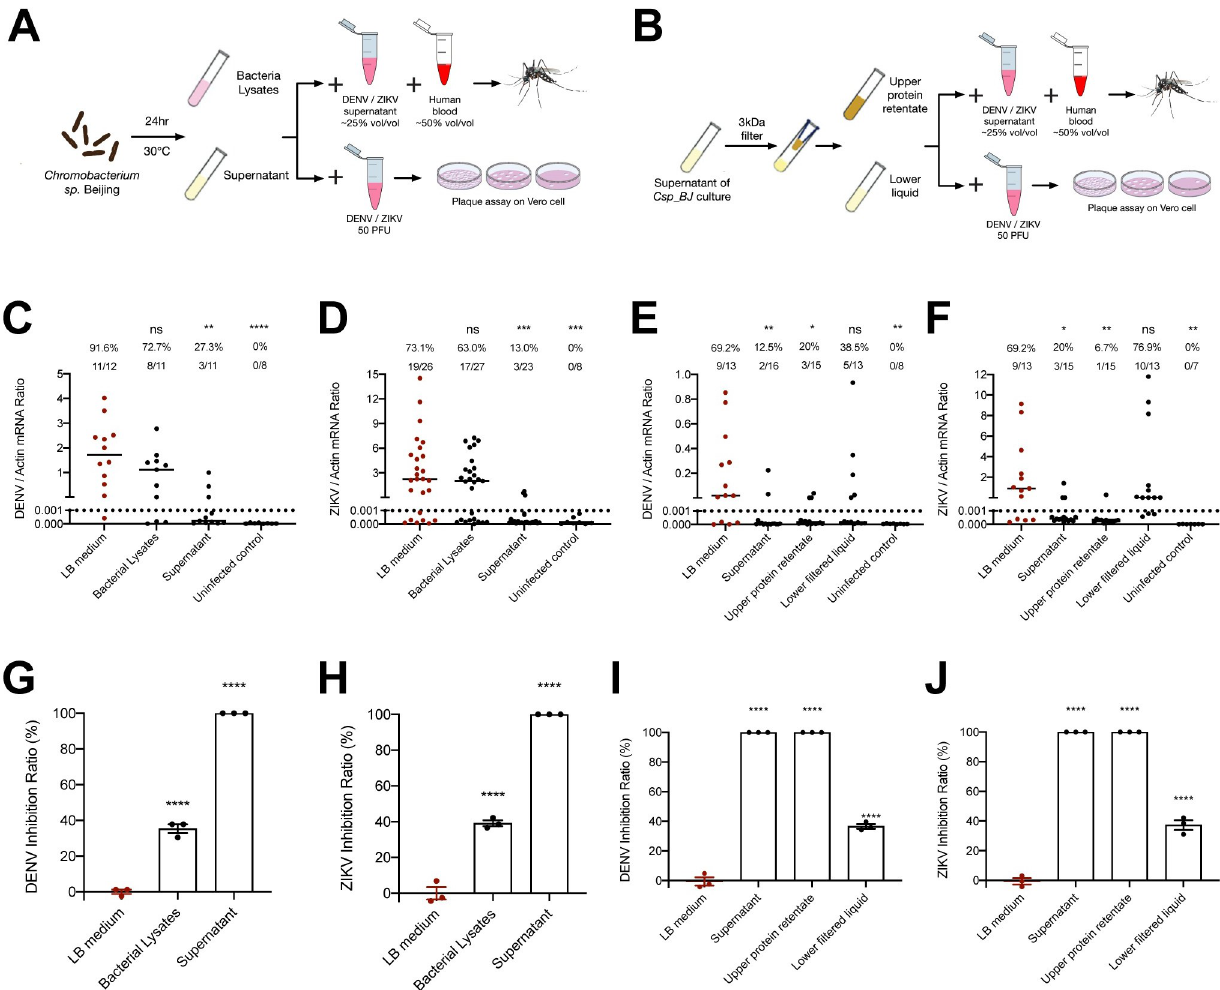
Fig 2. Secreted effector(s) from Csp_BJ inhibit DENV and ZIKV infection in both A . aegypti and Vero cells. (A, B) Schematic representation of the study design. (A) A Csp_BJ suspension was separated into bacterial cells and culture supernatant by centrifugation. Either the bacterial cell lysate or the culture supernatant (25% v/v) was mixed with human blood (50% v/v) and DENV or ZIKV virus supernatant (25% v/v) for membrane blood feeding of antibiotic-treated A . aegypti . Either the bacterial lysates or the culture supernatant (50% v/v) mixed with 50 PFU of DENV or ZIKV in VP-SFM medium (50% v/v) were incubated for 1 hr before being used for infection of Vero cell monolayers. Positive and negative controls are described in details in the Materials and Methods section. (B) Either the upper retentate or the lower liquid filtrate (25% v/v) was mixed with human blood (50% v/v) and the viruses (25% v/v) for membrane blood feeding of antibiotic-treated A . aegypti . Either the retentate or the filtrate (50% v/v) was mixed with 50 PFU of DENV or ZIKV in VP-SFM medium (50% v/v) and incubated for 1 hr before inoculation into Vero cell monolayers. Positive and negative controls are described in details in the Materials and Methods section. (A, B) Mosquito infectivity was determined by RT–qPCR at 8 days post blood meal. The final DENV or ZIKV titre was 1 × 10 5 PFU/mL for oral infection. (C, D, G, H) Secreted factor(s) from Csp_BJ inhibited DENV and ZIKV infection in mosquitoes or Vero cells. (C, D) Mosquito infection rate after oral supplementation of cell lysates or culture supernatant of Csp_BJ along with DENV (C) or ZIKV (D). (G, H) Inhibition rate in the presence of cell lysates or culture supernatant of Csp_BJ following infection by DENV (G) or ZIKV (H) in Vero cells, as determined by plaque formation assay. (E, F, I, J) Proteins in the supernatant inhibited DENV and ZIKV infection in mosquitoes or Vero cells. (E, F) Mosquito infection rate after oral supplementation of different components of Csp_BJ culture along with DENV (E) or ZIKV (F). (I, J) The inhibition rate in Vero cells was determined by plaque formation assay. (C-J) The number of infected mosquitoes relative to total mosquitoes is shown at the top of each column. Differences in the infectivity ratio were compared using Fisher’s exact test (C-F). Significance was determined by unpaired t tests (G-J). Data are presented as the mean ± SEM (G-J). P values were adjusted using the Benjamini–Hochberg procedure (C-F) or Dunnett’s test (G-J) to account for multiple comparisons. The P value represents a comparison between the mock group and the other groups. � P < 0.05, �� P < 0.01, ��� P < 0.001, ���� P < 0.0001, ns, not significant. The limit of detection is illustrated by dotted lines (C-F). Experiments consisted of at least three biological replicates, with similar results observed among the trials.